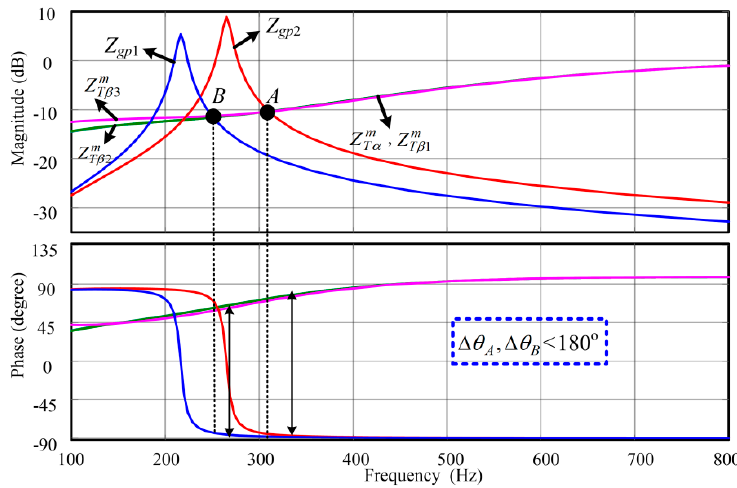
Figure 16. Bode plot of DFIG impedance and parallel compensated weak grid with low, medium, and high bandwidth improved PLL.